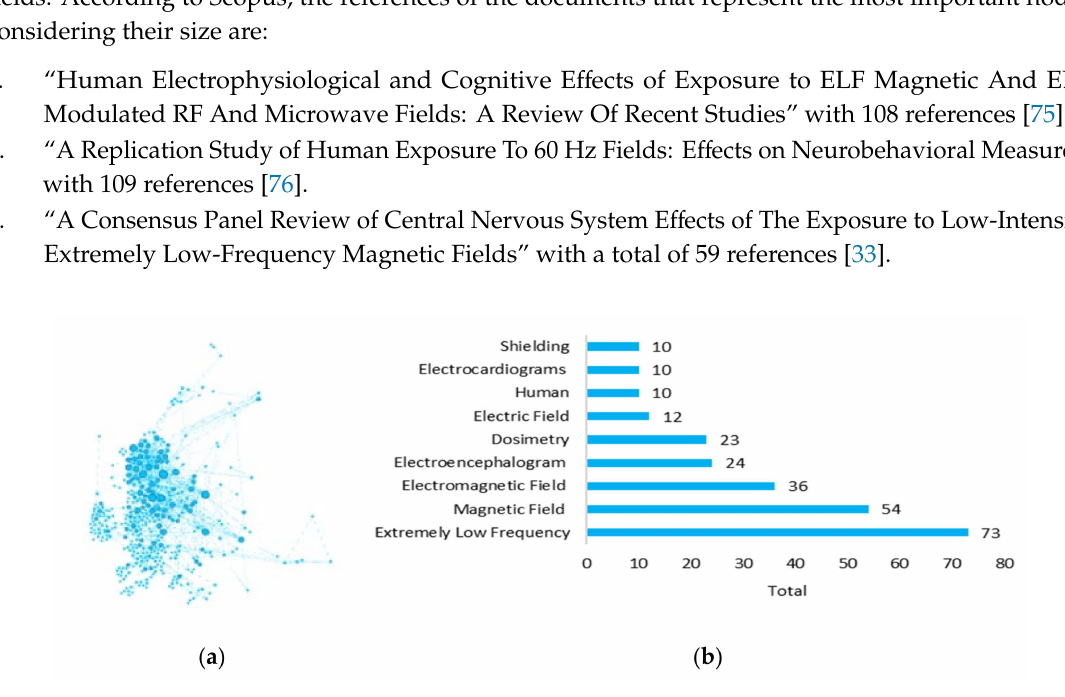
Figure 9. Representation of the electrophysiological e ff ects community: ( a ) isolated distribution of publications, ( b )